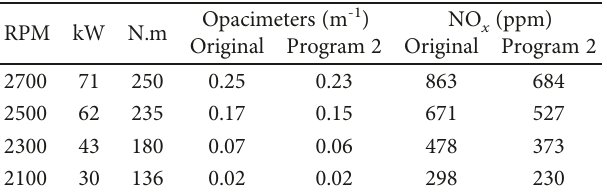
Table 4: Emission data under di ff erent operating conditions. RPM kW